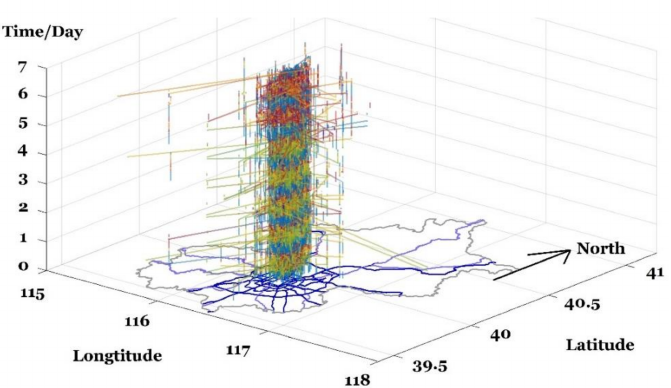
Figure 2. Distribution of Multiple-day Spatiotemporal Behavioral Trajectory of 680 Residents in the Shangdi-Qinghe Area,